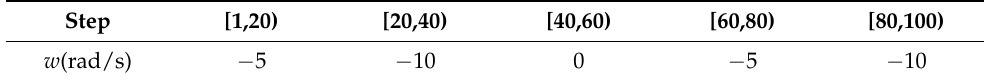
Table 1. Maneuvering